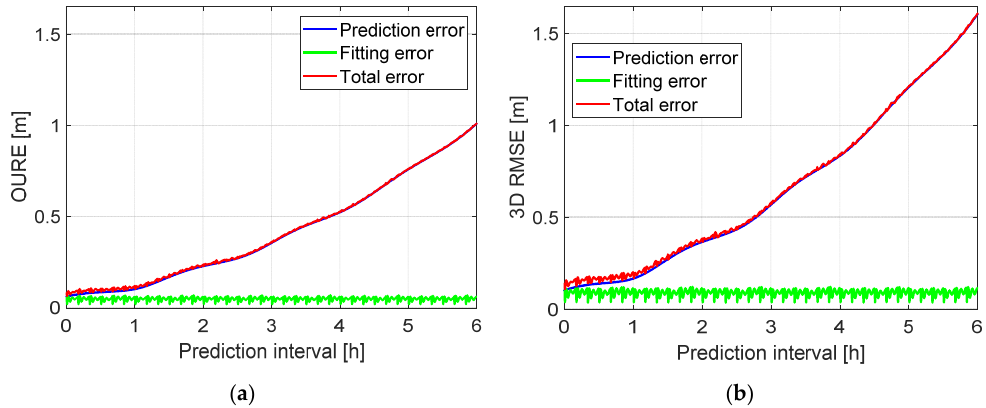
Figure 12. ( a ) The OURE and ( b ) the 3D RMSE of the prediction errors, the fitting errors and the total errors of the Level A orbital products. Table 7. The error budget of the Level A products at different prediction periods. Prediction interval